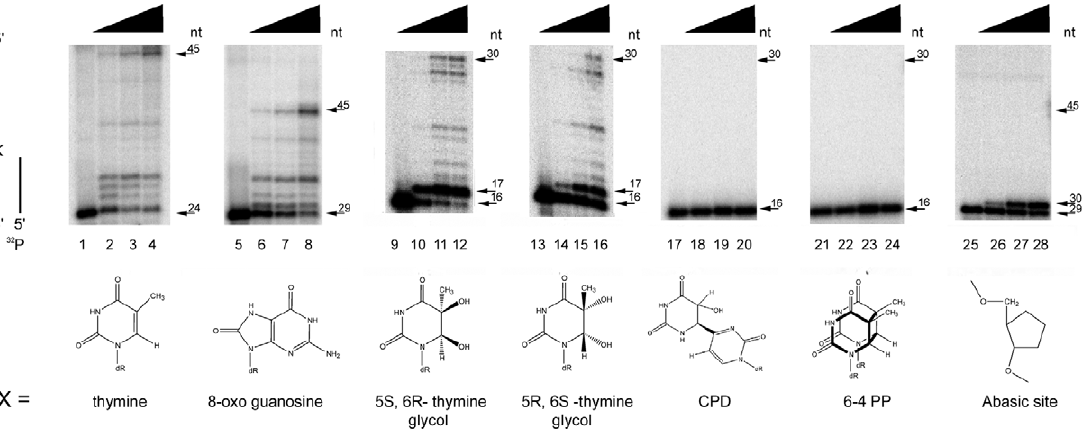
Figure 5. Translesion DNA synthesis by EhDNApolA. 16% denaturing polyacrylamide gel electrophoresis showing translesion bypass of EhDNApolA. The first templated base is denoted with an X. The structure of each templated lesion and a templated thymine are depicted for comparison. The reactions were incubated with increased amounts of EhDNApolA (0, 60, 120, and 240 fmol) and 20pM of each substrate. Thymine (lanes 1–4); 8-oxo guanosine (lanes 5–8,); 5 S-6R thymine glycol (lanes 9–12); 5R-6S thymine glycol (lanes 13–16,); cis-syn cyclobutane pyrimidine dimer (lanes 17–20); 6-4 photo product (lanes 21–24); abasic site (lanes 25–29). The bottom arrow indicates the substrate length and the top arrow indicates the expected full-length products.